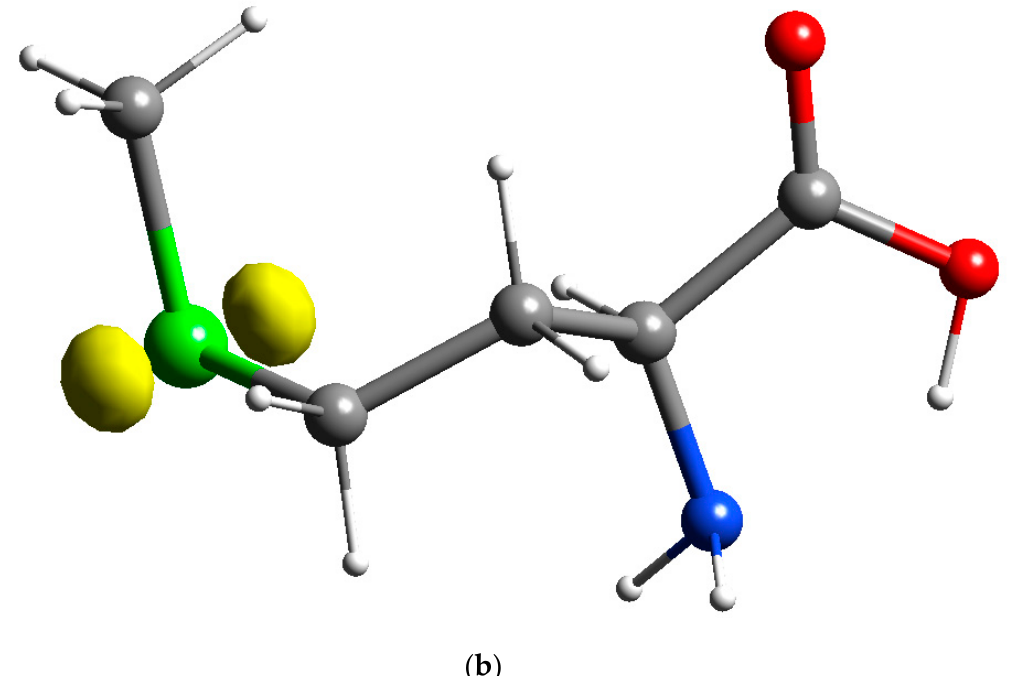
Figure 5. Fukui results of methionine: ( a ) Reduction sites of methionine f + ( r ) for PMCPE (isosurface value of 0.02); ( b ) Oxidation sites of methionine f − ( r ) for PMCPE (isosurface value of 0.02).